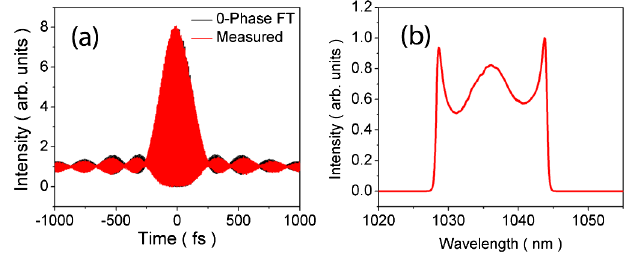
FIG. 8. The ANDi fiber laser characterization: (a) the second- order autocorrelation, the black curve is the 0-phase spectrum Fourier transform (FT), the red curve is from measurement; (b) the spectrum.